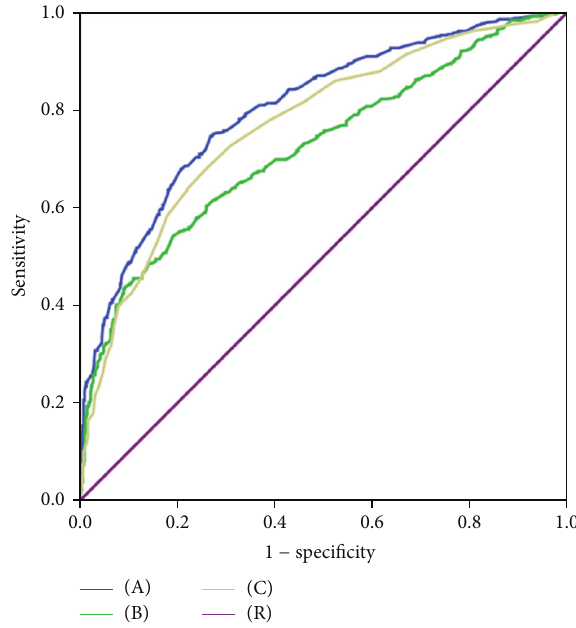
Figure 1: Receiver operating characteristic (ROC) curve of FBG, HbA1c, and OGTT 2 h plasma glucose for need of AIT. (A) FBG at time of OGTT; (B) OGTT 2h plasma glucose; (C) HbA1c at time of OGTT; (R) reference